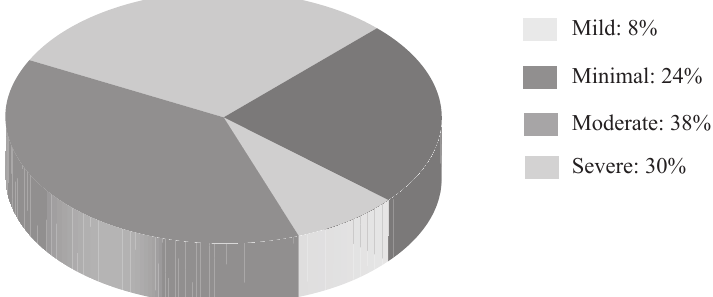
Figure 2. Severity of the lesions identified in male soccer athletes in the city of Aracaju - season